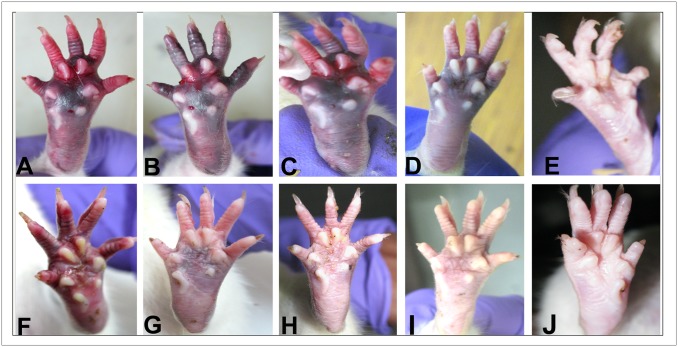
Recovery of thrombosis at rat footpad by the plant fibrinolytic enzymes.
(A-D), after generation of thrombus as described in the text, the following components was applied at 0 hr, (A) PBS (100 μl); (B) plant extract (10 mg/kg); (C) purified enzyme (5 mg/kg) and (D) plasmin (1 mg/kg). In (E), plant extract was applied where no thrombus was generated beforehand to serve as a control to check inherent thrombolytic activity of the extract. Conditions of the corresponding set after 24 h have been illustrated in (F-J). While F shows little recovery out of natural healing, (J) demonstrates that the plant extract is free from thrombolytic activity. Variable degrees of recoveries are evident in (G-I).